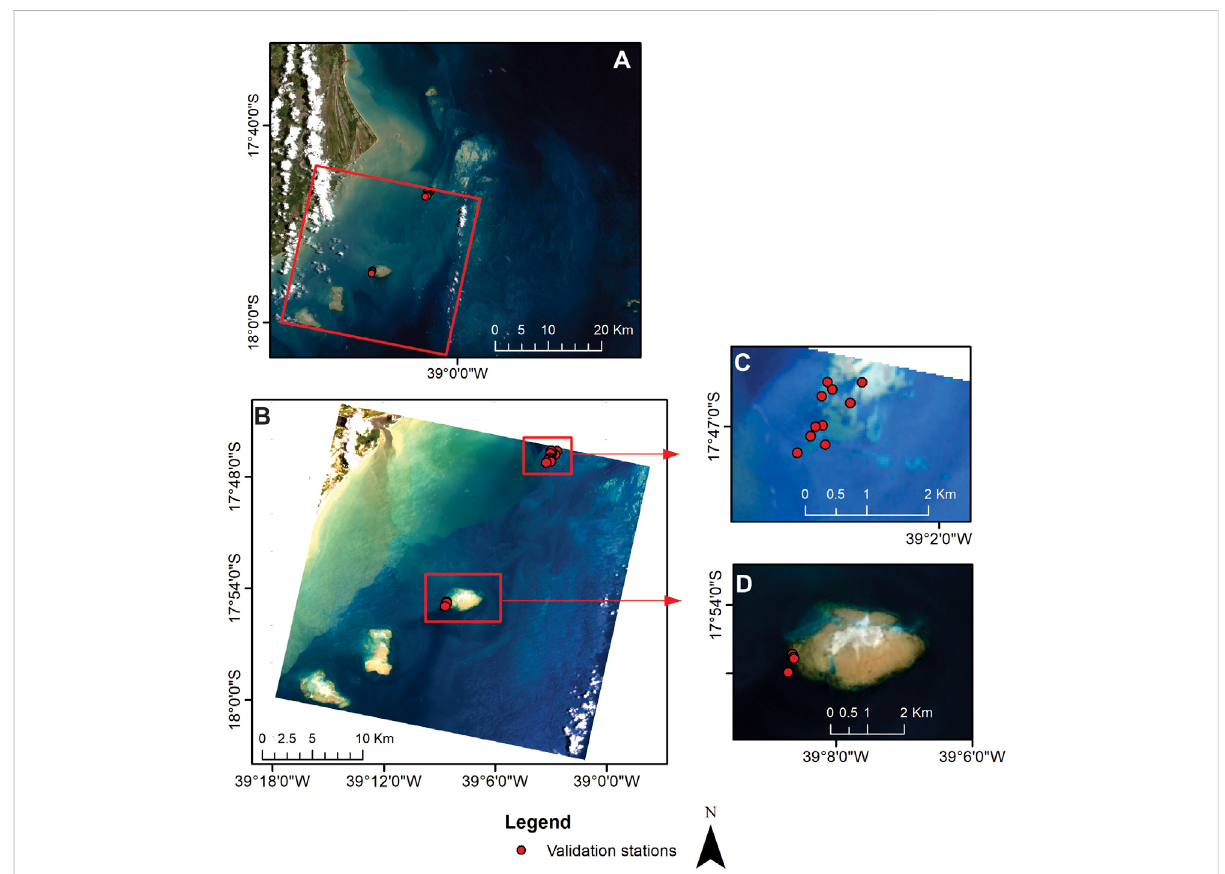
FIGURE 3 AbrolhosBankRegion(ABR). (A) CBERS-4image(truecolorcomposition),redrectangleindicatestheboundariesofthePRISMAimage. (B) Sub- area of the PRISMA image (red box) showing the sampling stations visited during the 2013 fi eld campaign within the inner arc and used for model validation. (C) Detailoftheareaofinterestwiththesamplingstationsat PedradoLeste reef. (D) Detailoftheareaofinterestwiththesamplingstations at Sebastião Gomes